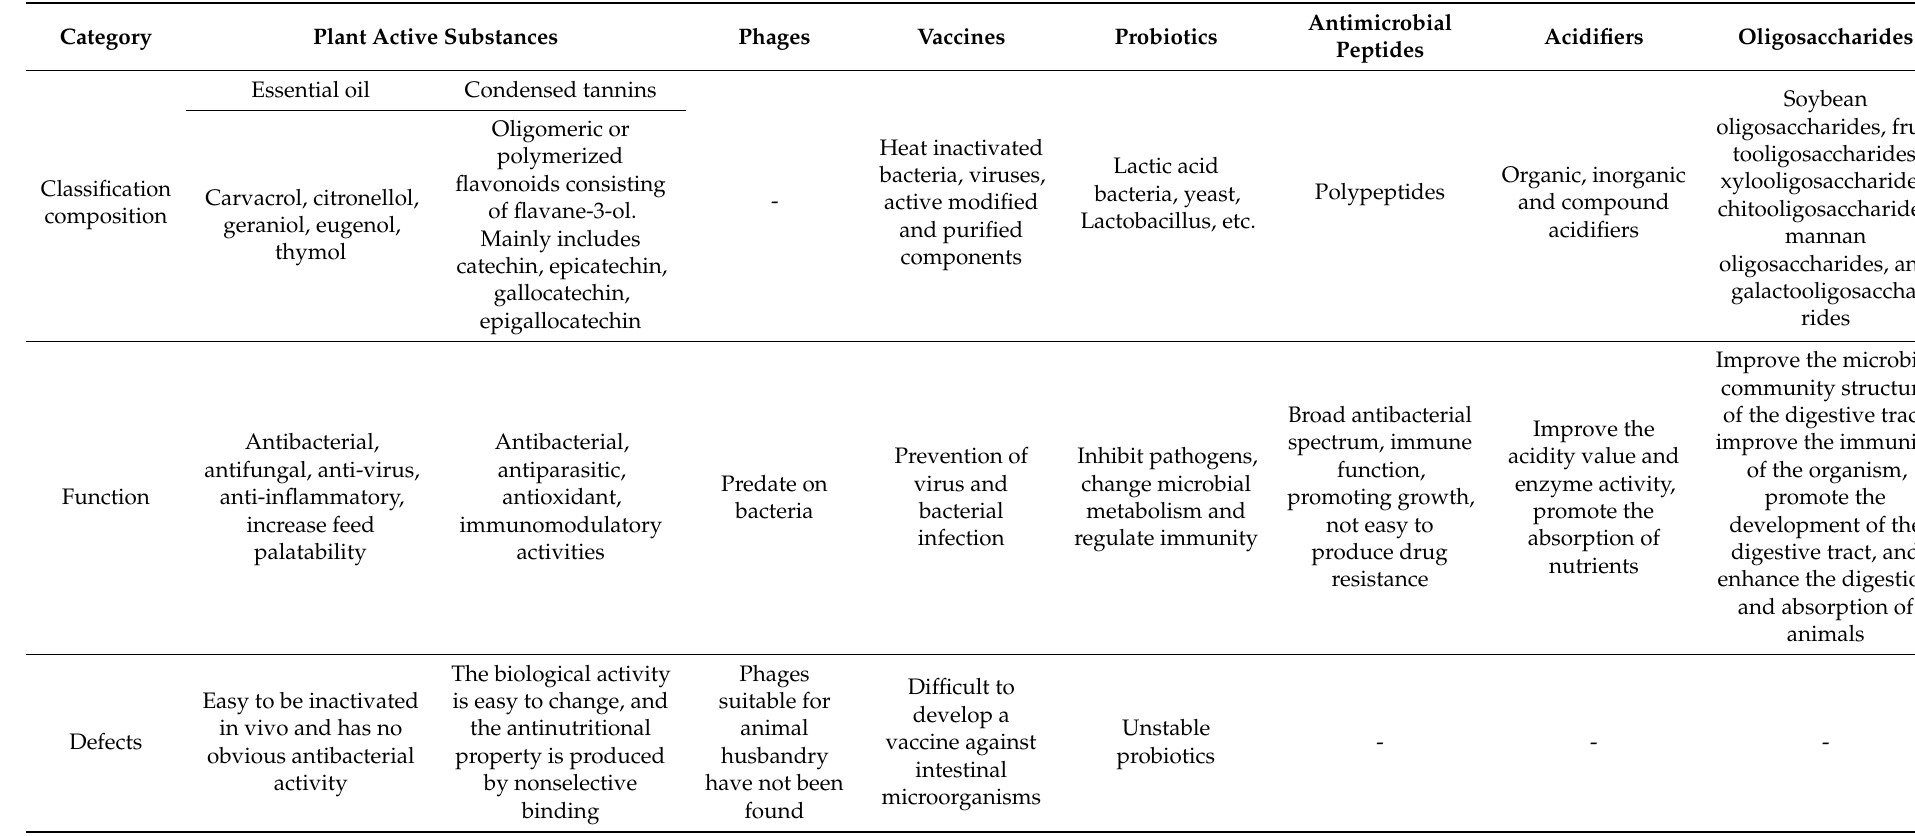
Table 2. Classification of Antibiotic